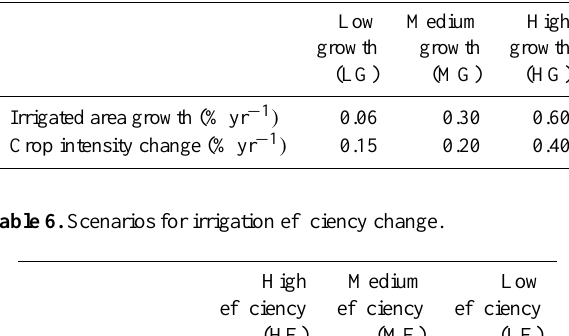
Table 5. Scenarios for irrigated area growth and crop intensity change.